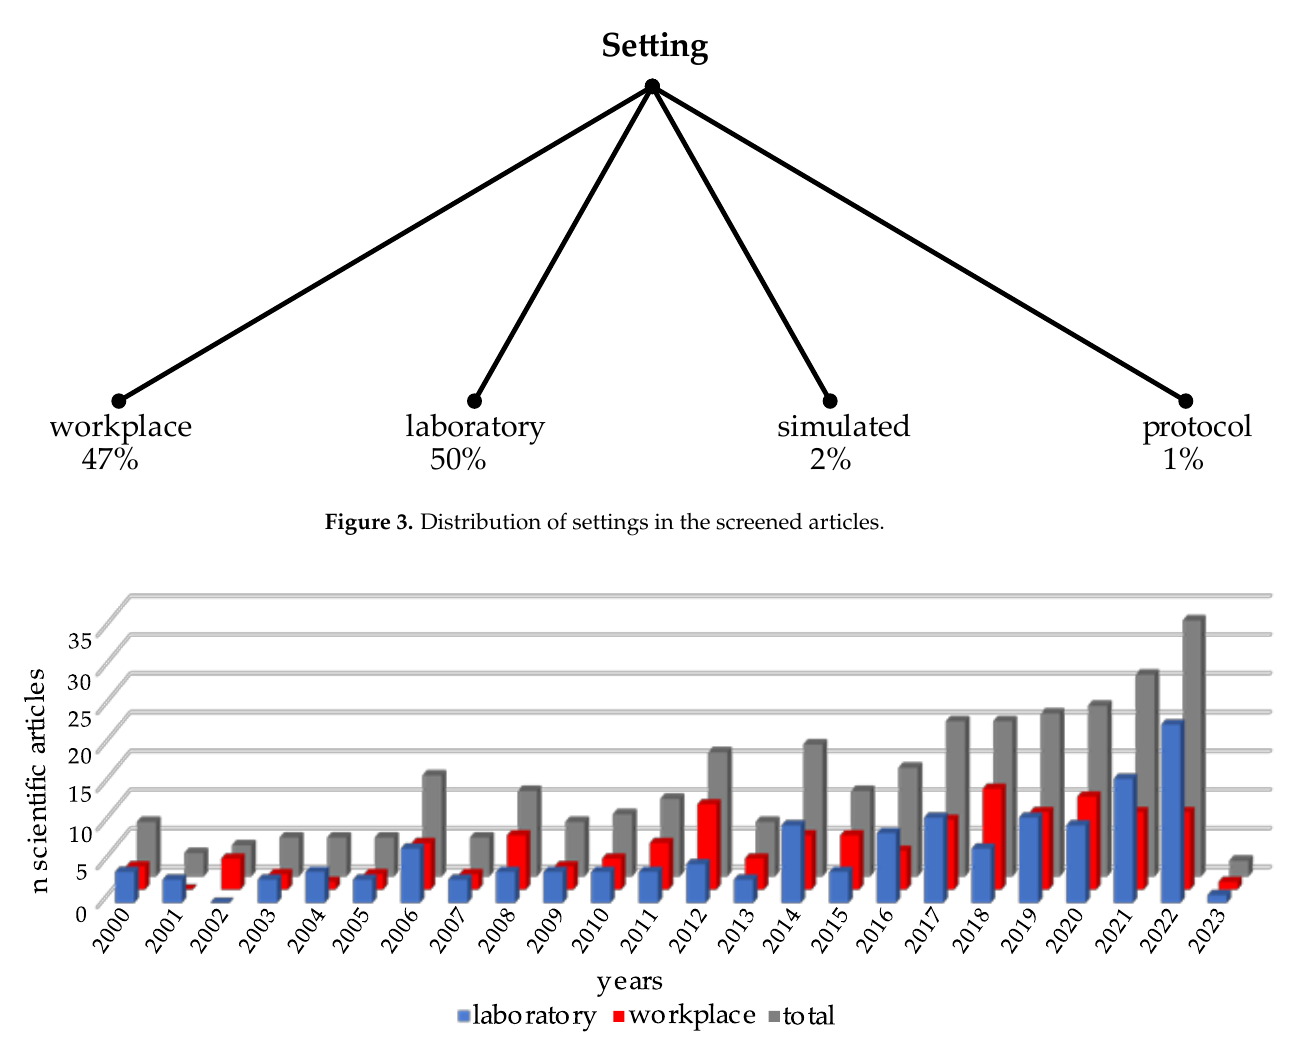
Figure 4. Temporal distribution (number of scientific articles published per year) of the screened scientific articles from the year 2000 to December 2022, for laboratory settings (blue), working places (red) and overall (grey). Some scientific articles that were already accepted and will be published in 2023 are